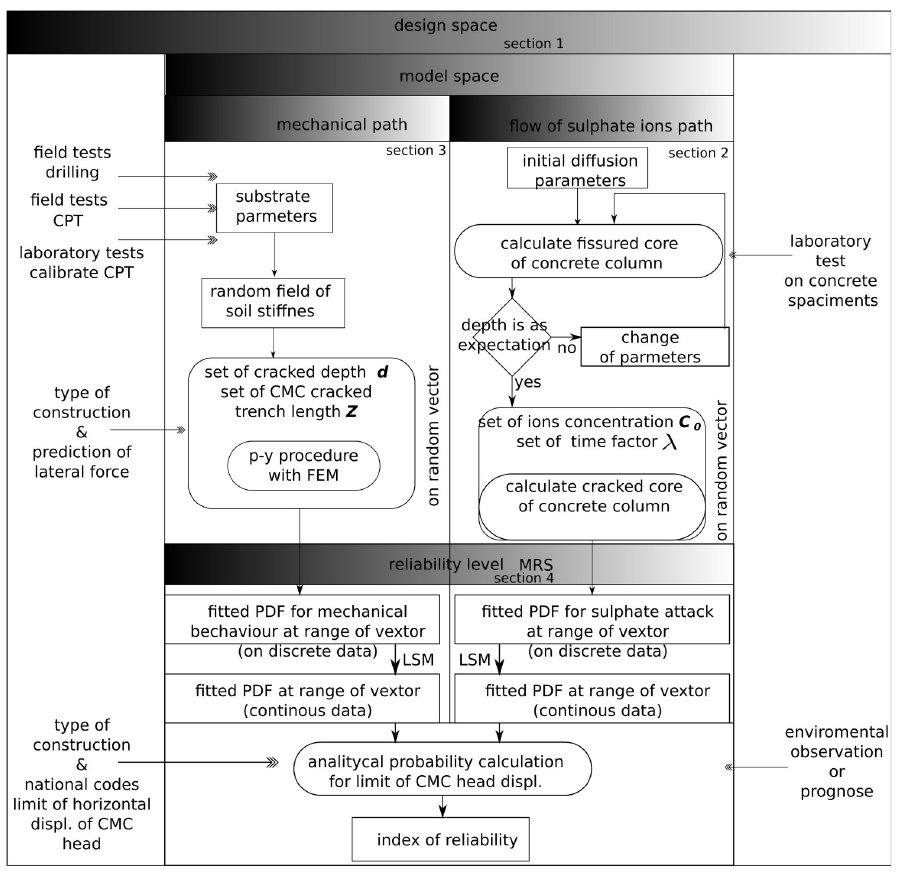
Fig 9. Flow diagram of procedures for describing and modelling object under environmental